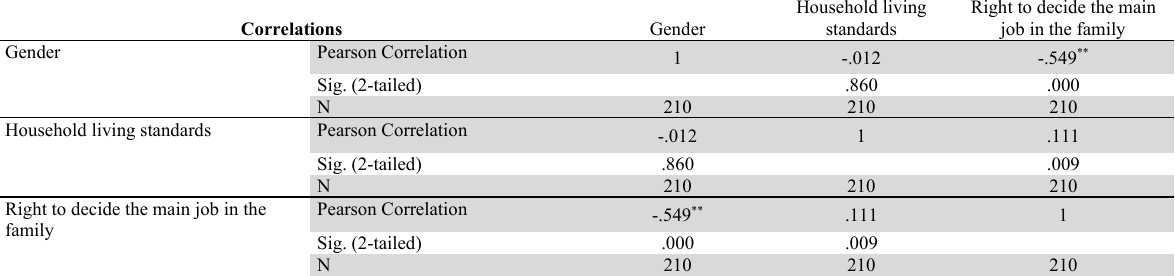
Correlation of decision-making power in income-generating activities by gender and standard of living Correlations Gender